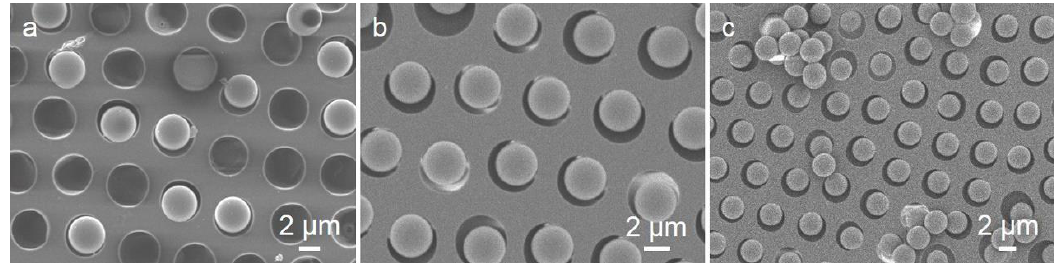
Figure 4. SEM images of PS microspheres filled into the cavities with contents of ( a ) 0.05% w / v , ( b ) 0.1% w / v , and ( c ) 0.2% w / v , respectively.